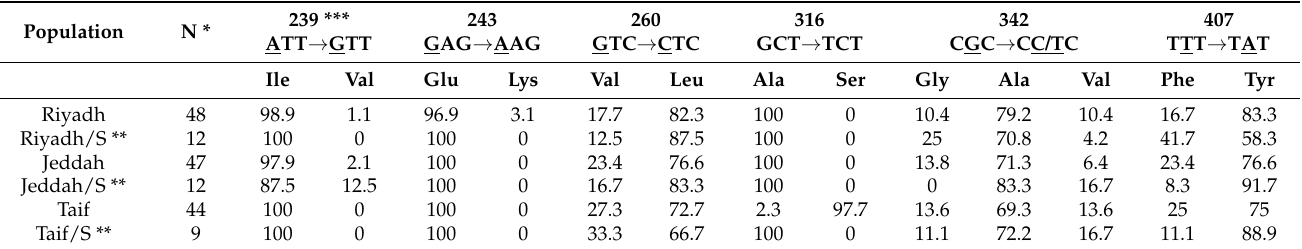
Table 2. Frequency of Ace point mutation responsible for MP-resistance in house fly populations, collected from three slaughterhouses in Saudi